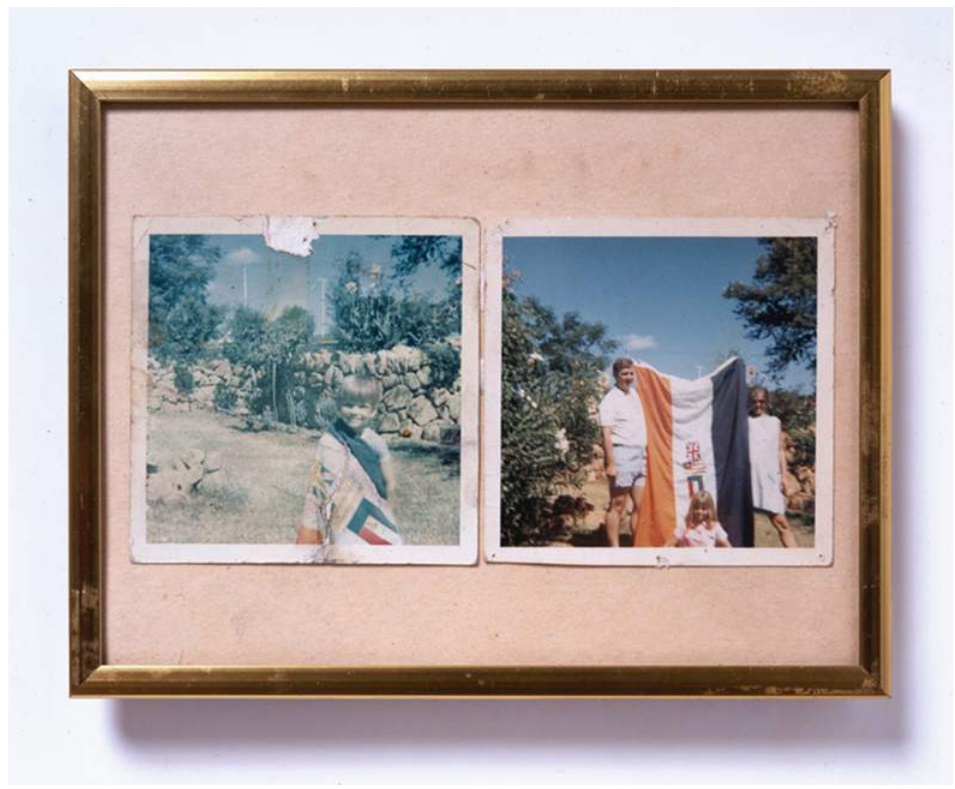
Brett Murray, Guilt and Innocence (detail), 1997. Site-specific installation (photo: courtesy the artist and Goodman Gallery, Cape